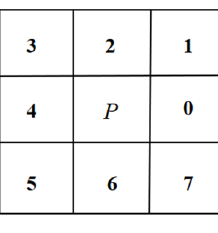
Figure 7. Eight-way chain code direction representation.